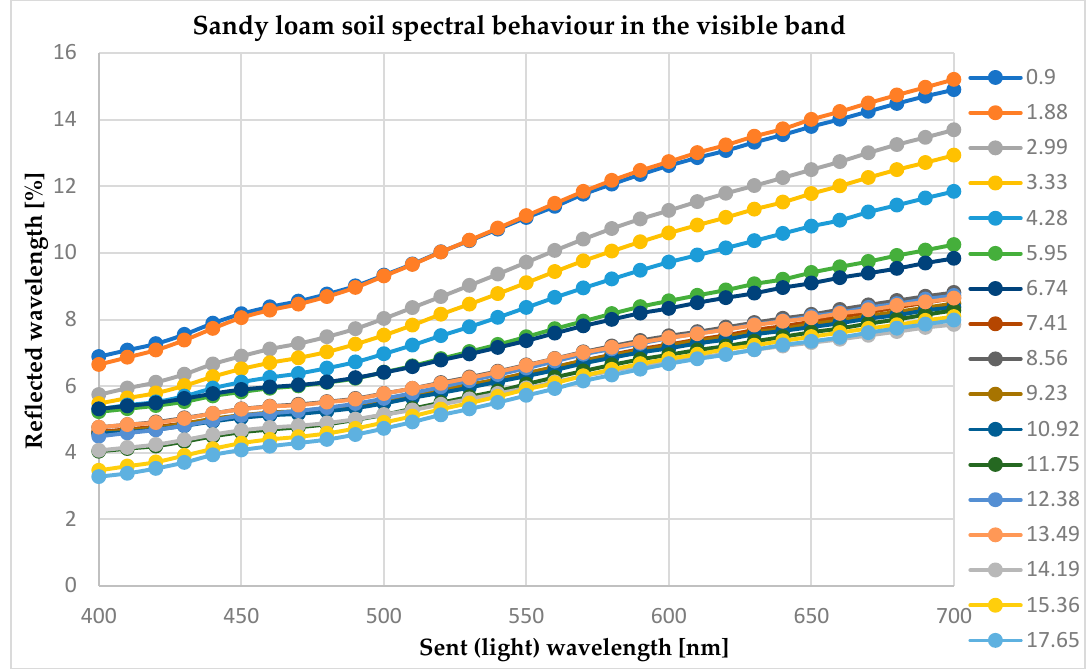
Figure 8. Sandy loam soil colour reflected wavelength at different moisture contents .